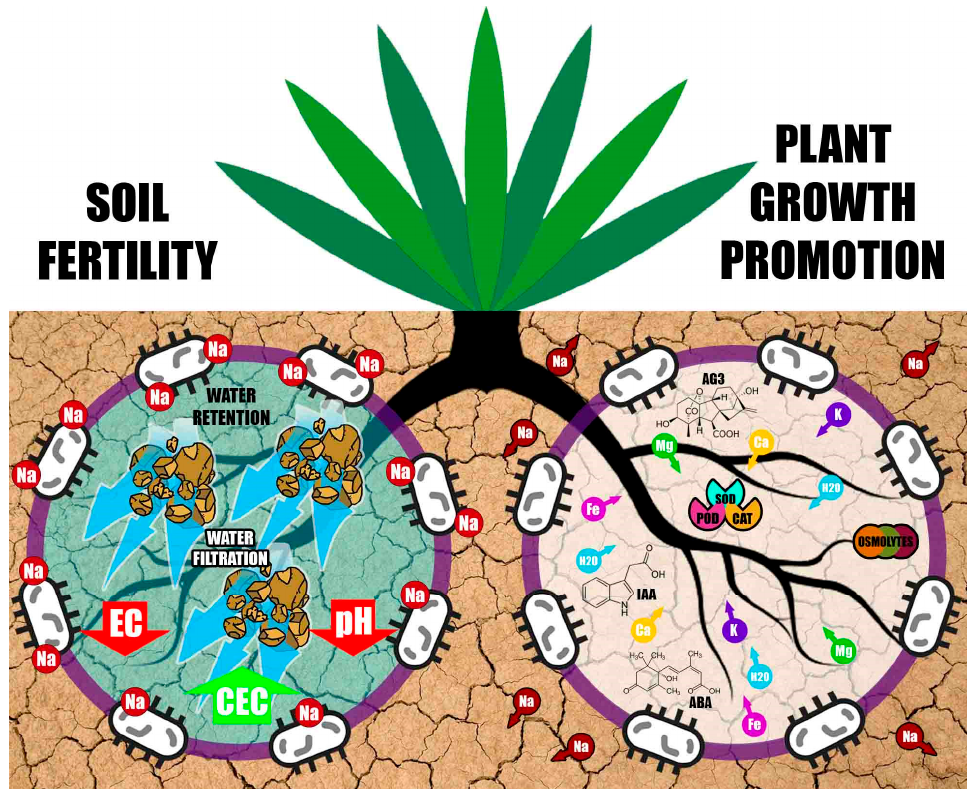
Figure 1. Effect of halotolerant PGPR bacteria on soil and the plant under high salinity. The exopolysaccharide produced by halobacteria plays a key role in Na + sequestration and the consequent reduction in soil electrical conductivity (EC). Besides, it favors the formation of aggregates in soil, with macro and micropores that improve water filtration and retention. It also increases cation exchange capacity (CEC), decreases the pH and improves nutrient availability. Altogether, these contribute to increase soil fertility. On the other side, halobacteria solubilize nutrients, release osmolytes, antioxidant enzymes (SOD = Superoxide dismutase, CAT = Catalase, POD = Peroxidase), auxins (IAA = Indol acetic-acid), gibberellins (AG3 = Gibberellic acid), stress signaling and adaptation molecules (ABA = Abscisic acid) that favor plant growth and protection against salinity, and improve water retention and Na + extrusion thanks to the